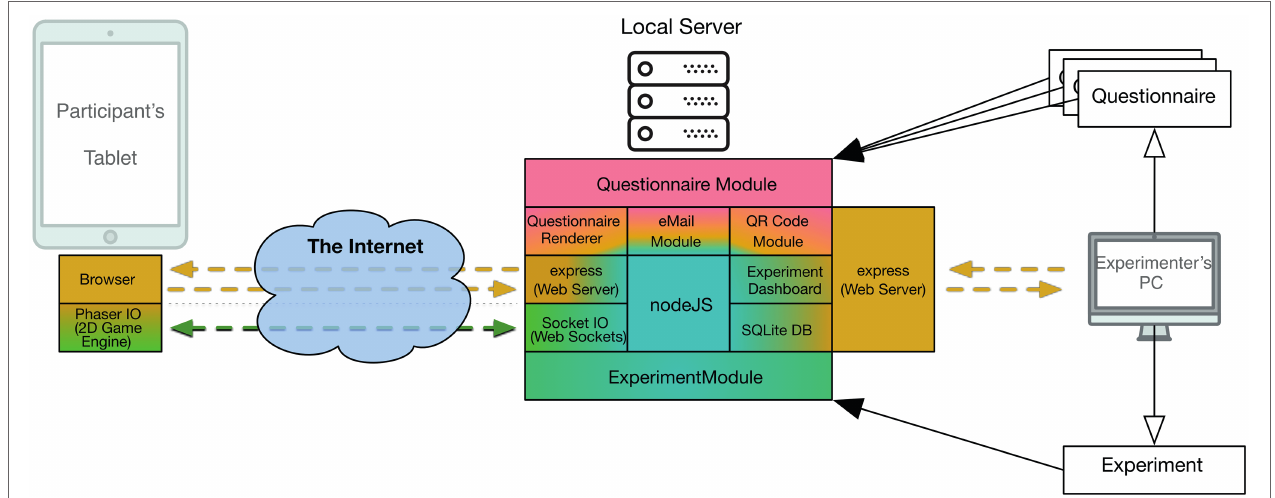
FIGURE 1 | Schematics of the parts and modules in the ReActLab